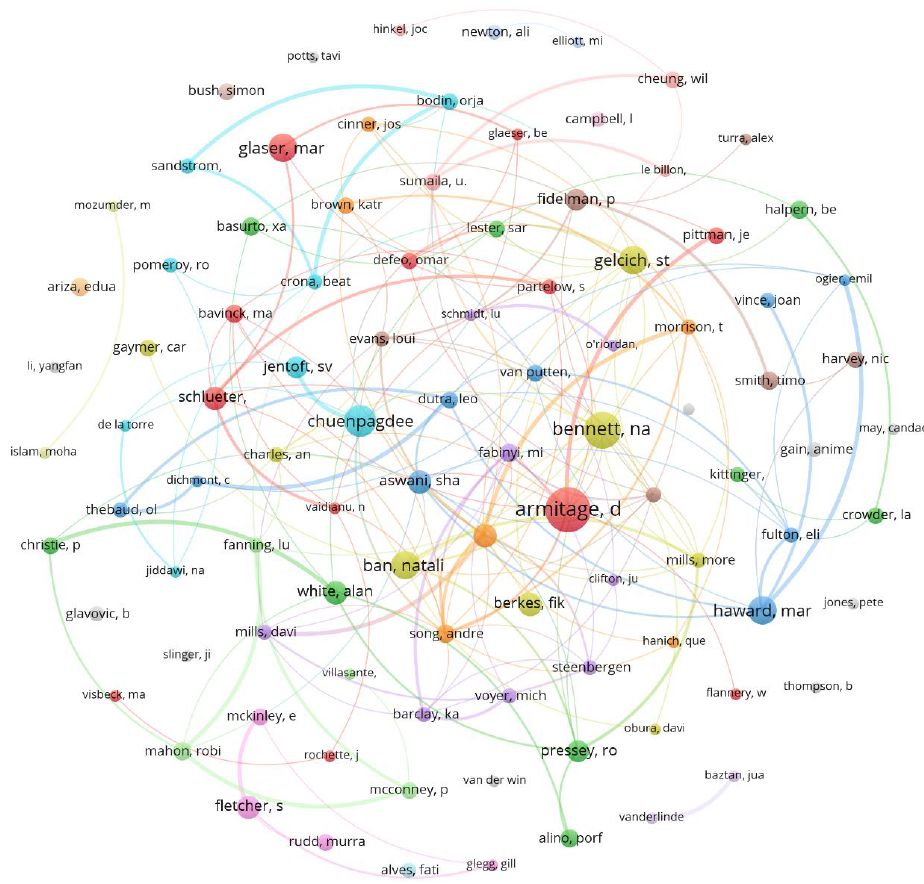
Figure 3. Co-authorship network, main researchers. Table 3. Authors with the highest production in the co-authorship main researcher